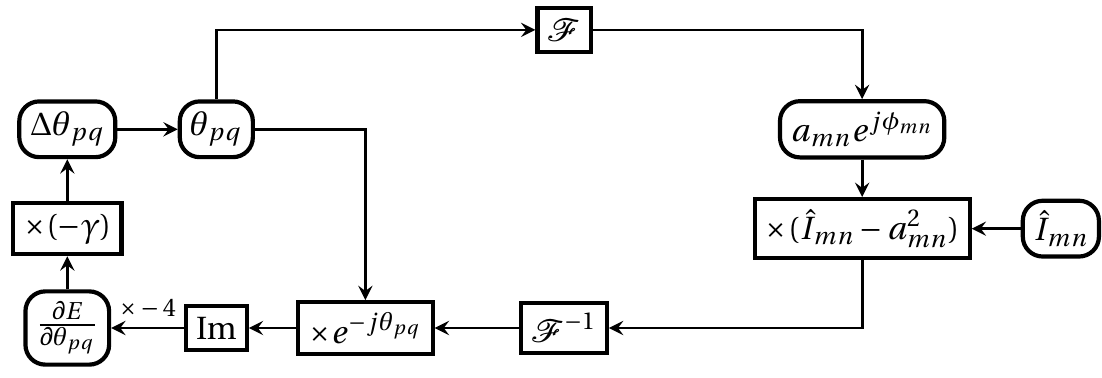
Figure 2. Calculation process of the proposed